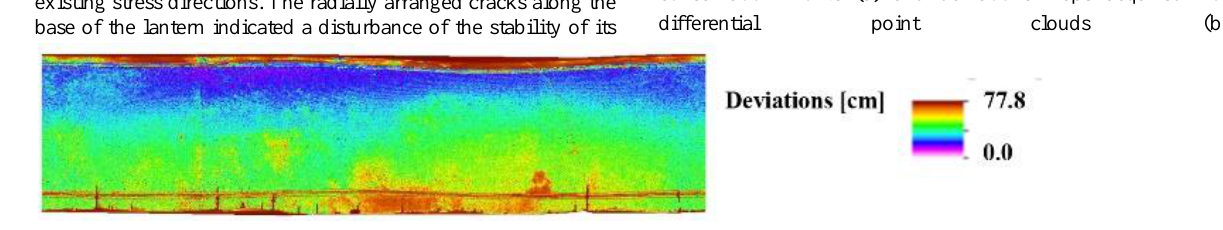
Figure 6: The deviation map acquired from differential point